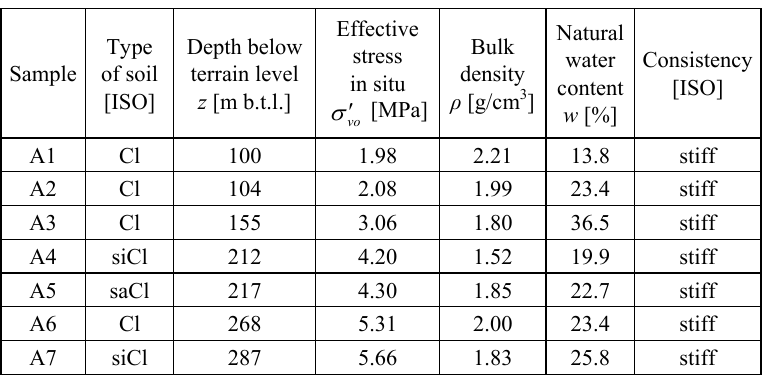
Table 1. Characteristic of soil specimens